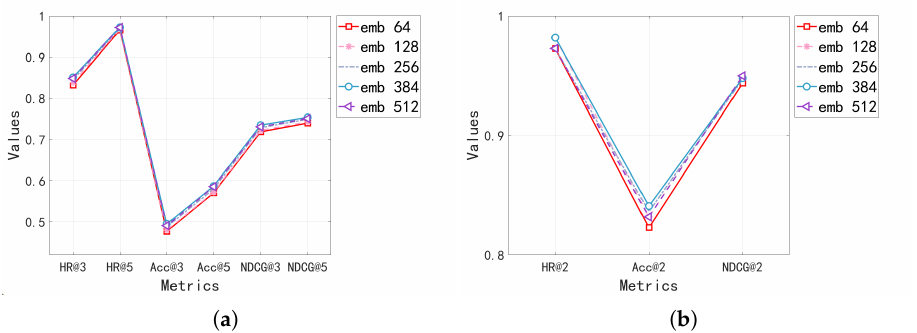
Figure 6. Performances of Different Embedding Dimensions on Two Datasets. ( a ) Telecom Dataset . ( b ) Talking Dataset